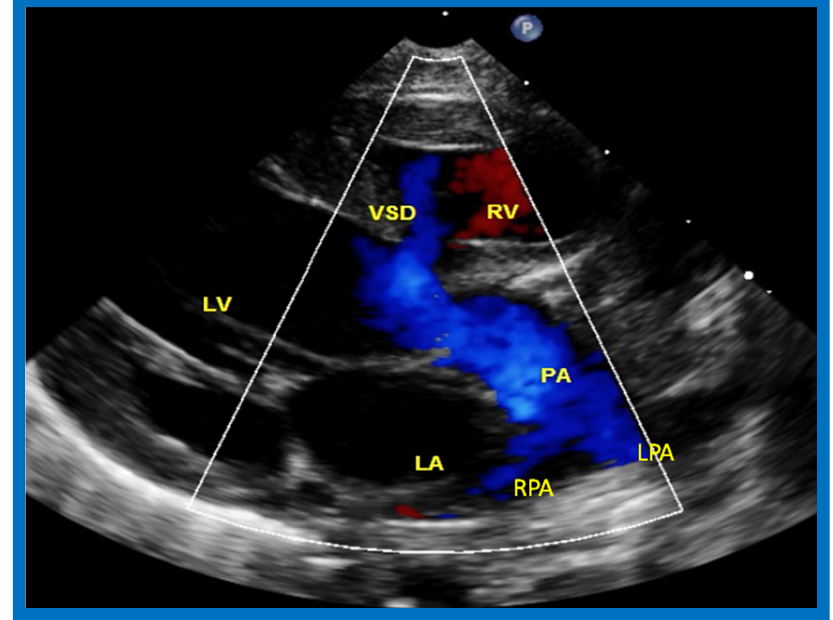
Figure 22. Selected video frame from precordial long axis view with color flow mapping of another